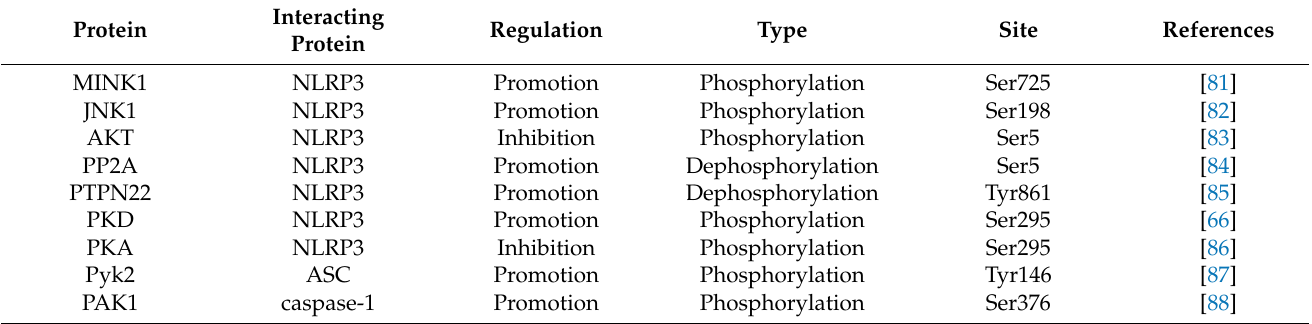
Table 2. Phosphorylation and dephosphorylation of NLRP3 inflammasome